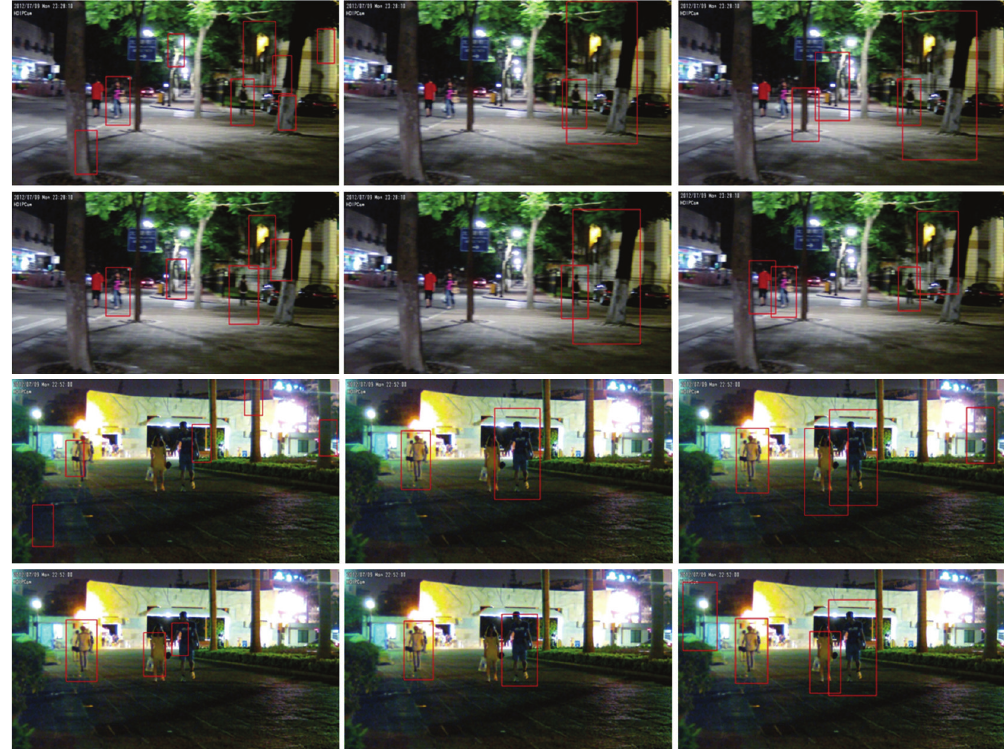
Figure 10: Detection results on XMU-NIR. From left to right and top to down, the classifiers are HOG lin, LBP lin, HOG LBP lin, HOG HIK, LBP HIK, and HOG LBP